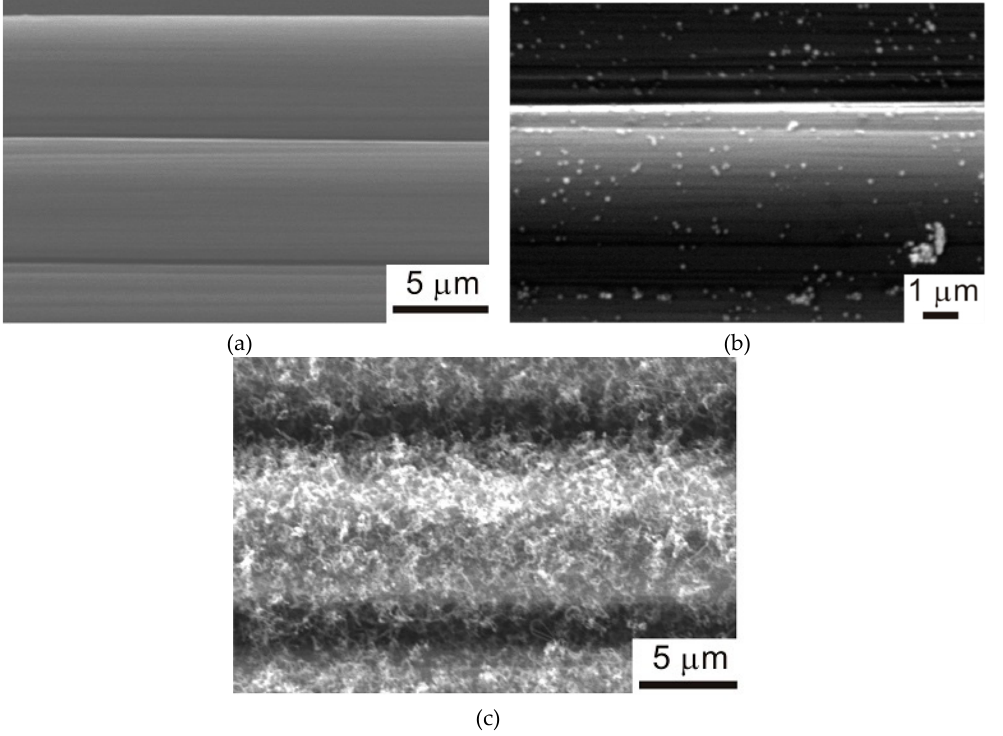
Figure 5. SEM images of each carbon fiber. ( a ) Carbon fiber (CF). ( b ) Ni-CF. ( c ) Carbon nanofilaments (CNF)-CF.